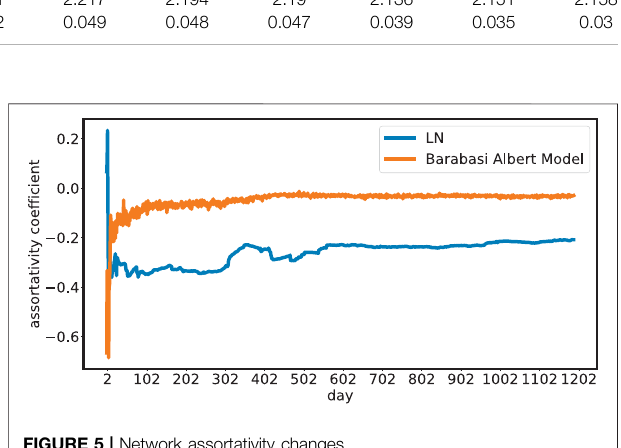
FIGURE 5 | Network assortativity